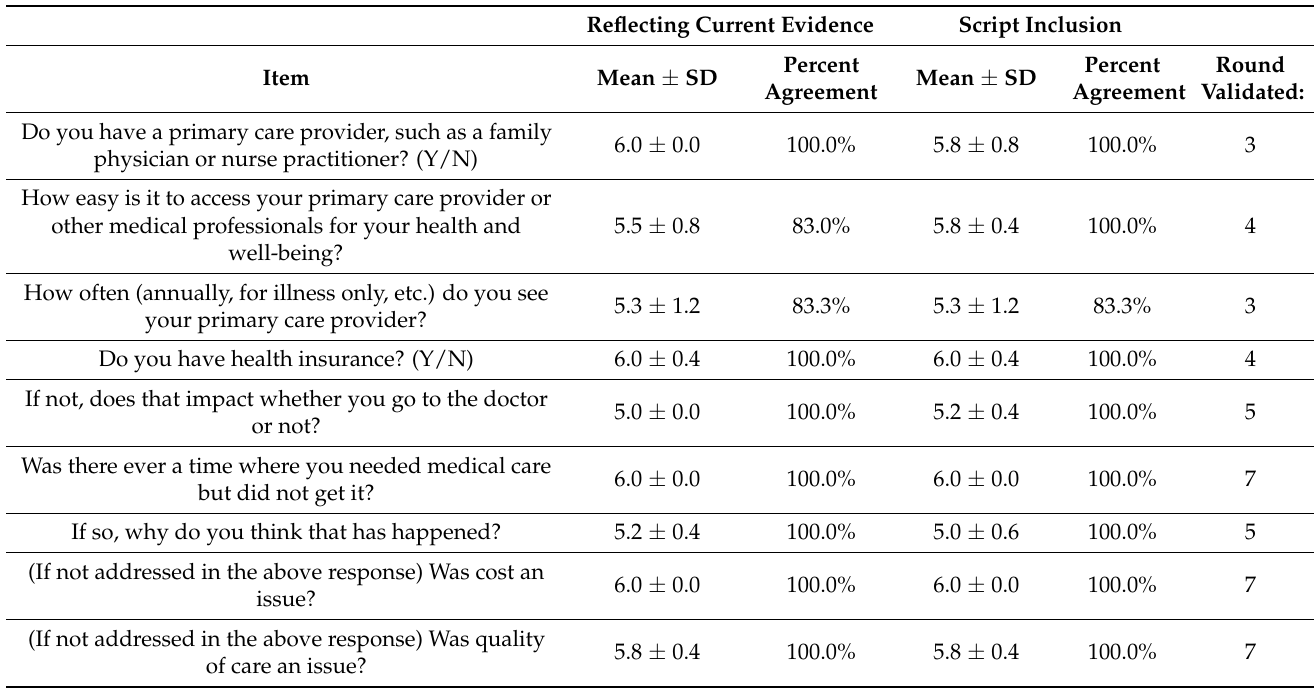
Table 2. Final Script Item